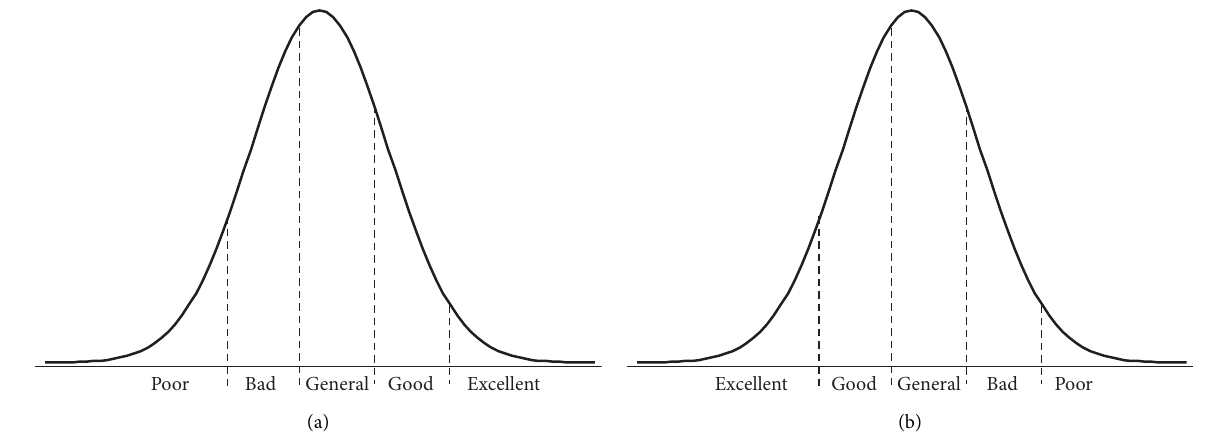
Figure 2: Fuzzy evaluation rating division of reputation evaluation indicators. Table 3: The critical value of the rating 1–5 scale of the reputation evaluation